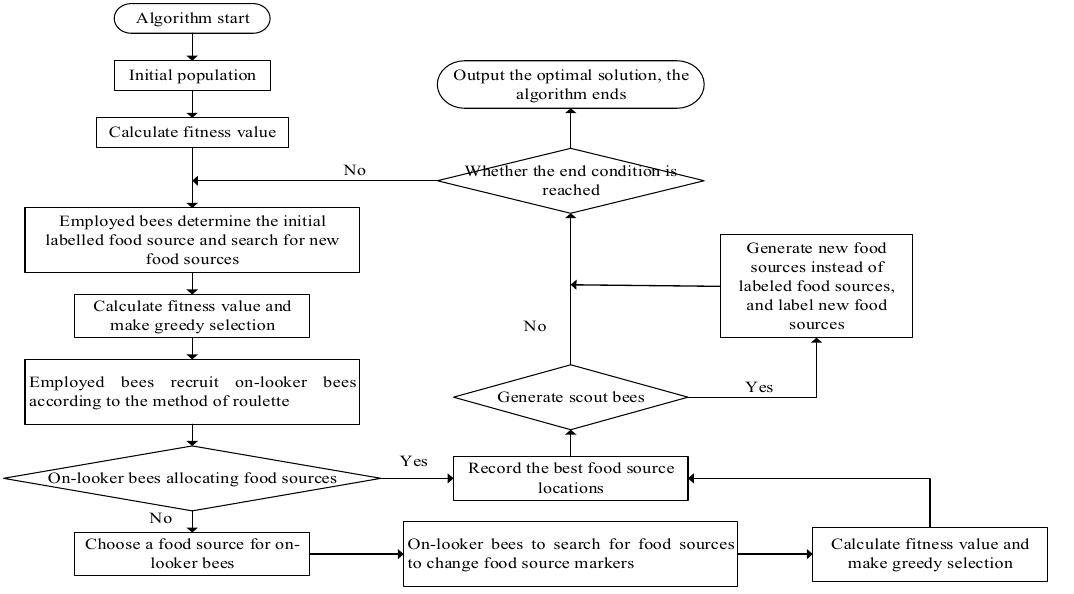
Figure 4. Flow chart of